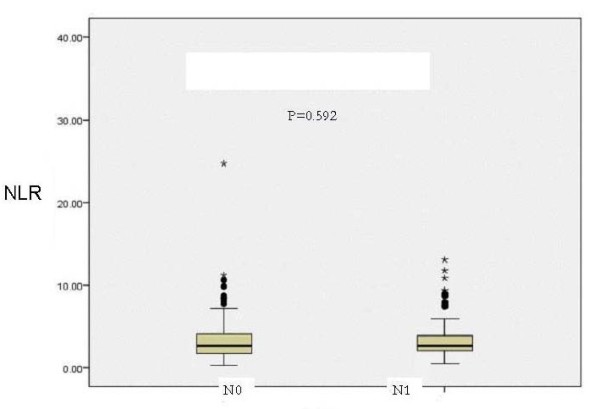
NLR value and TNM nodal status.